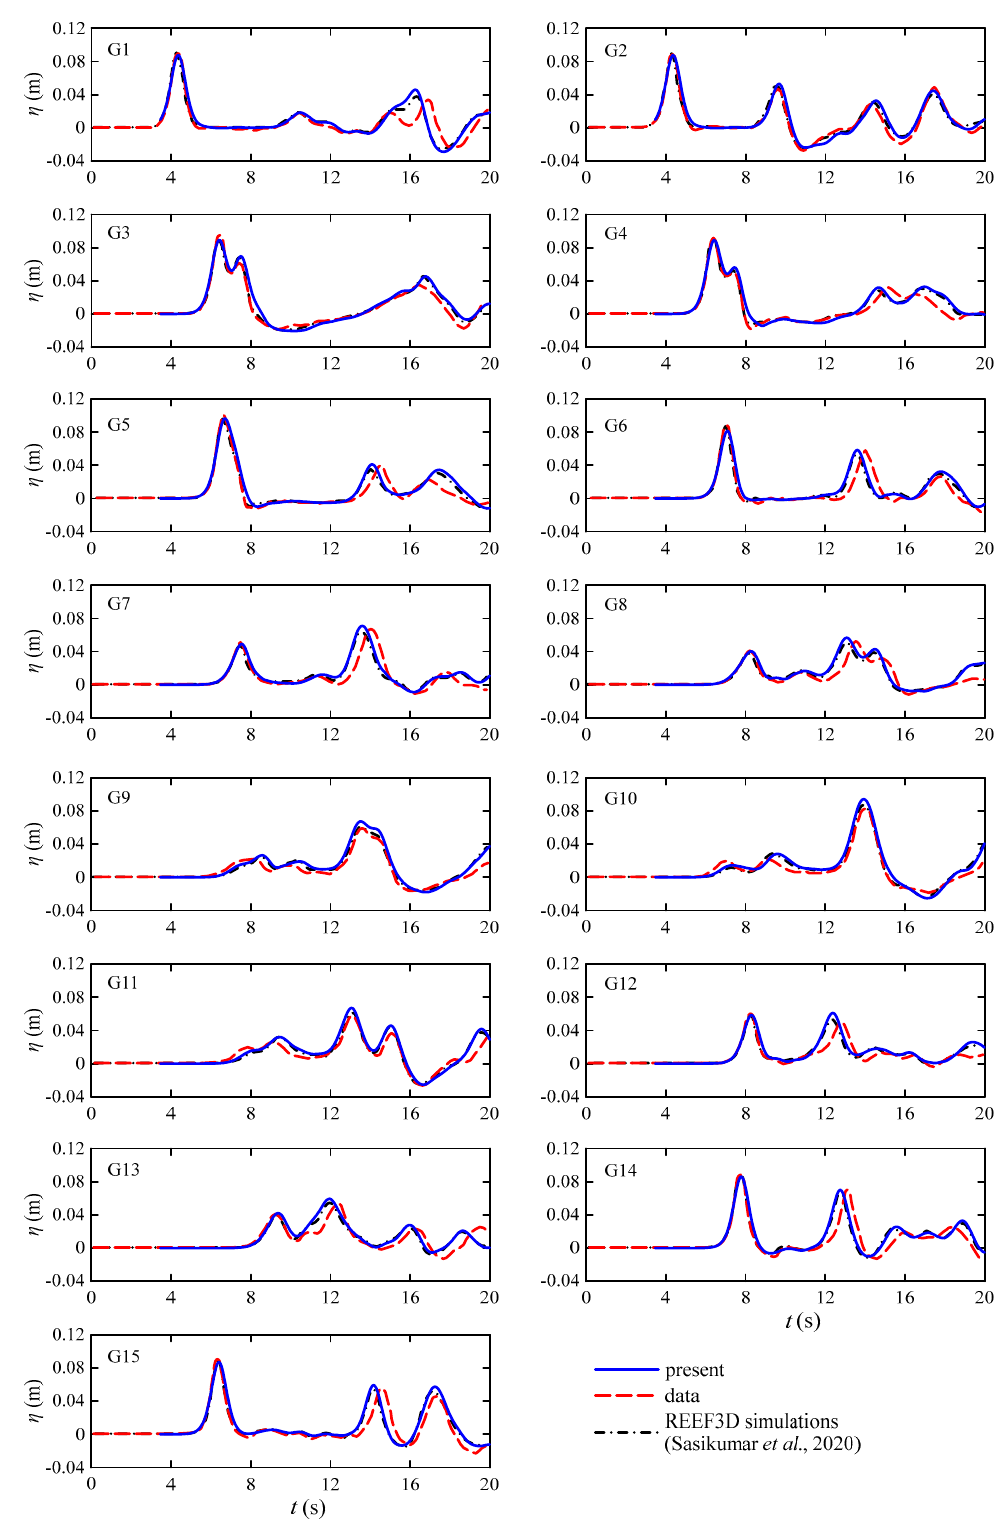
Figure 12. Time series of surface elevation for solitary wave propagation through porous